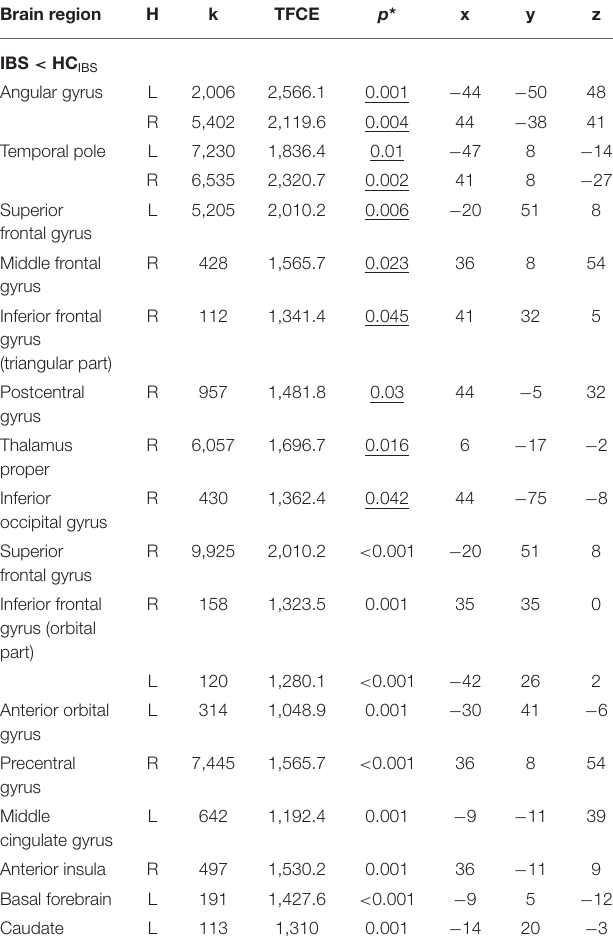
TABLE 4 | Results of multiple regression correlating gray matter volume and chronic stress in patients with IBS and healthy controls. Brain